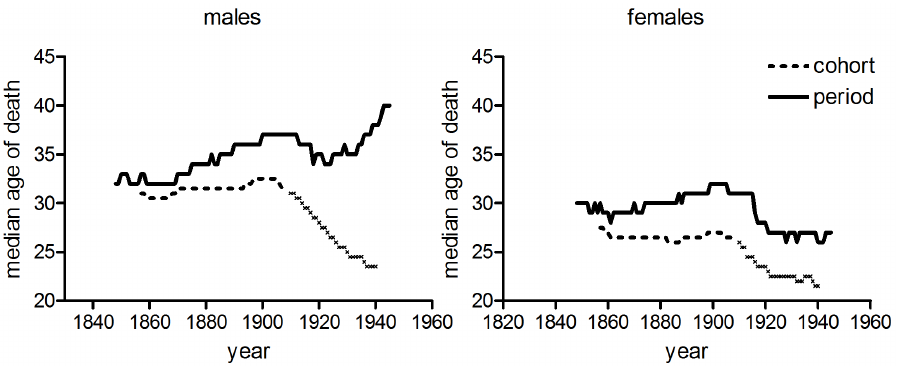
Figure 5. Median age at death from tuberculosis, by annual birth cohort, England and Wales. Median age was calculated by indirect standardisation of deaths at ages 10–79 years, and plotted at the year when the cohort was aged 20.